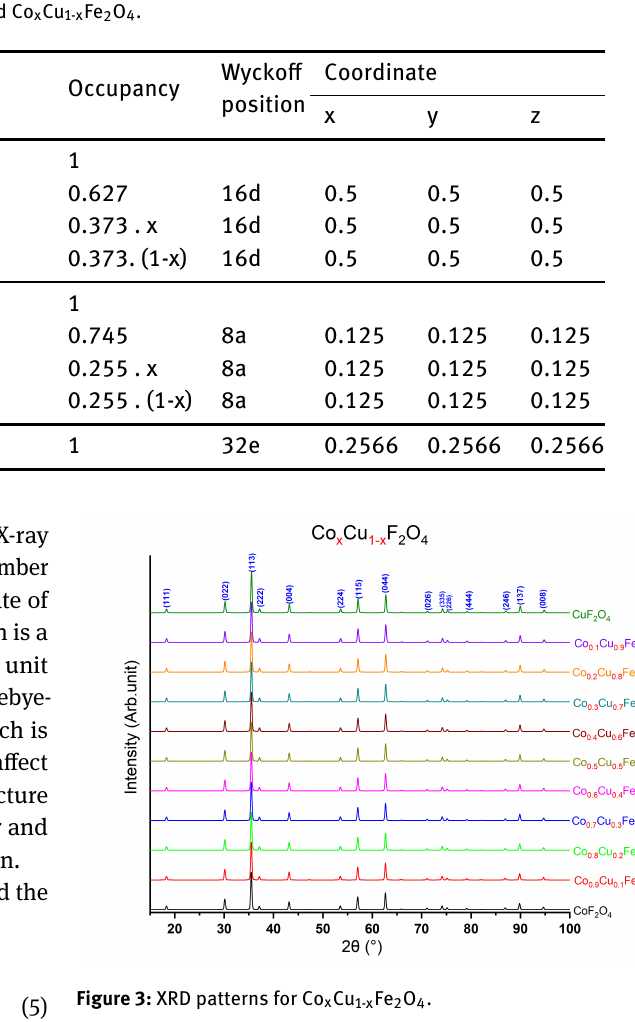
Table 1: Substitution of Cu +2 with Co +2 in AB 2 X 4 system to build Co x Cu 1-x Fe 2 O 4 .